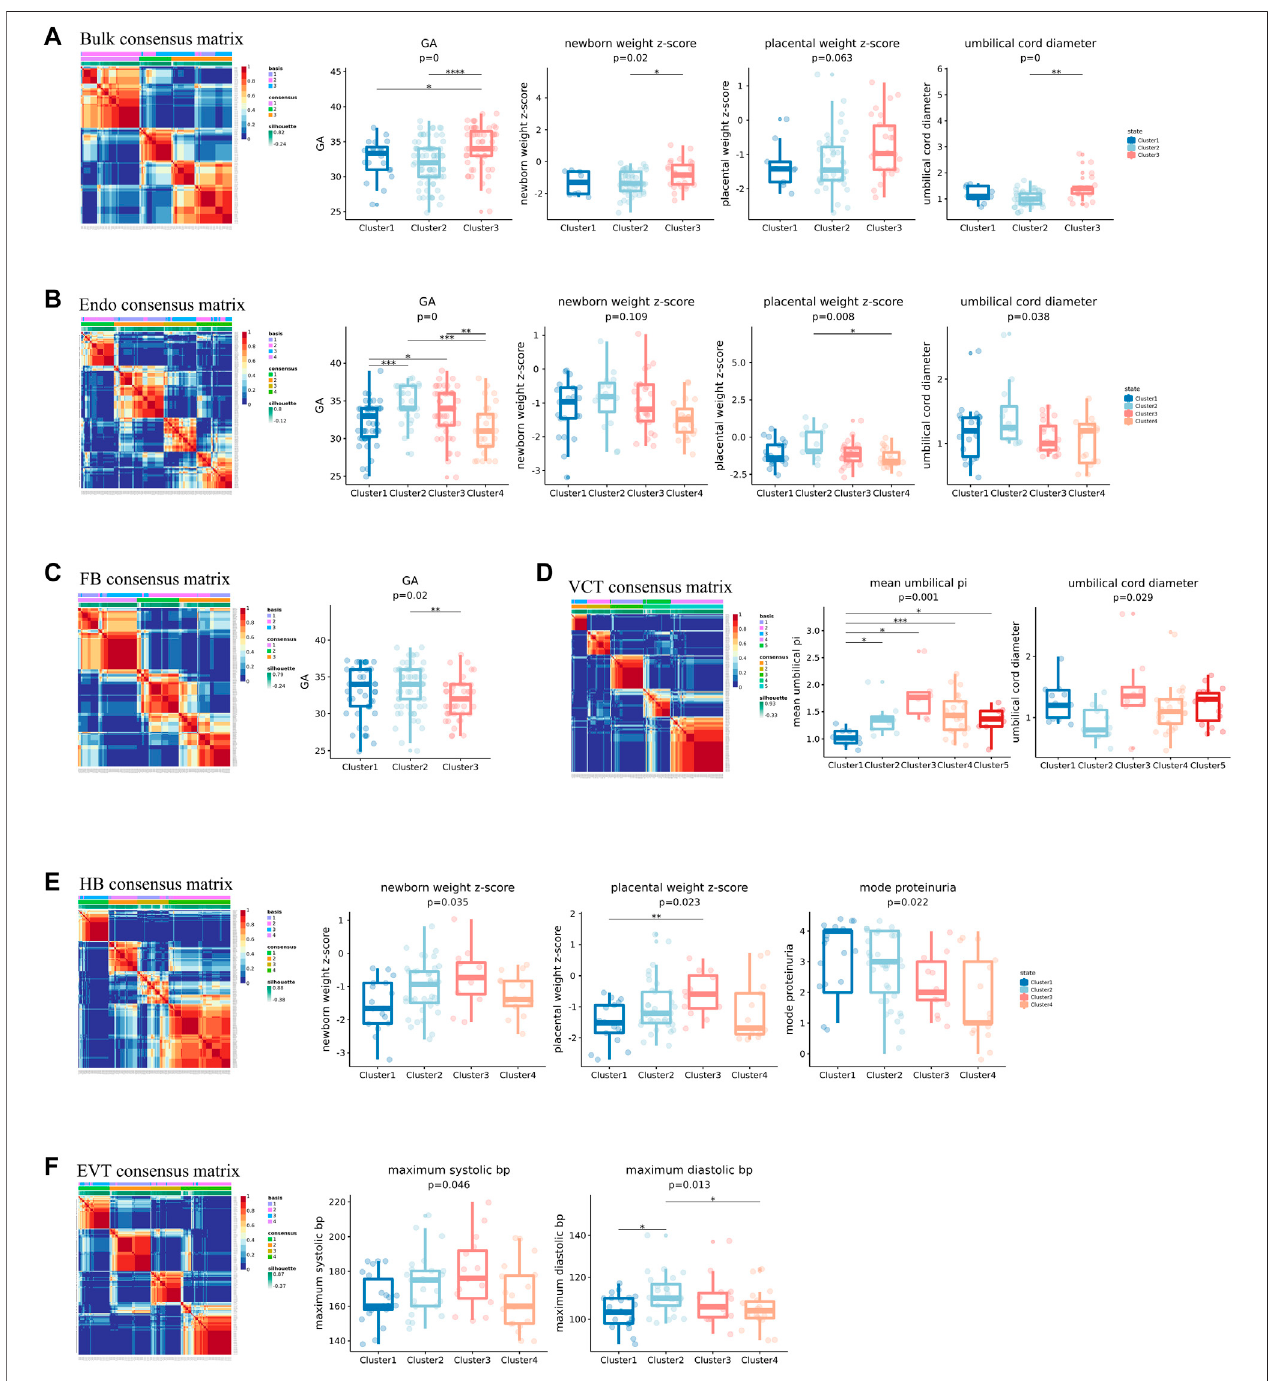
FIGURE 5 | Unsupervised clustering of PE samples using the bulk or predicted cell-type-level expression pro fi les. The expression pro fi les used in (A – F) were the bulk, the predicted cell-type-level expression pro fi les of Endo, FB, VCT, HB and EVT, respectively. In each of (A – F) , the clinical phenotypes signi fi cantly associated with the clustering were